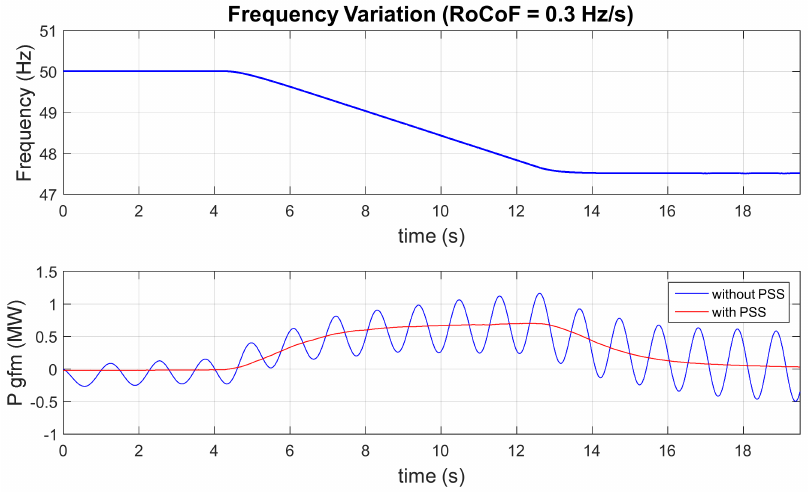
Figure 11. Active power provided by the VSC at a frequency variation with and without